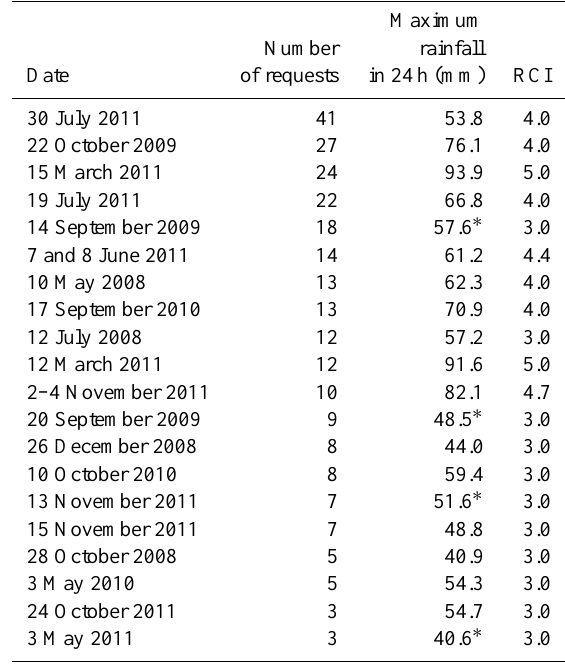
Table 2. Rain events in Barcelona during 2008–2011 exceeding 40mm in 24h, number of requests received in the SMC, and RCI, without considering